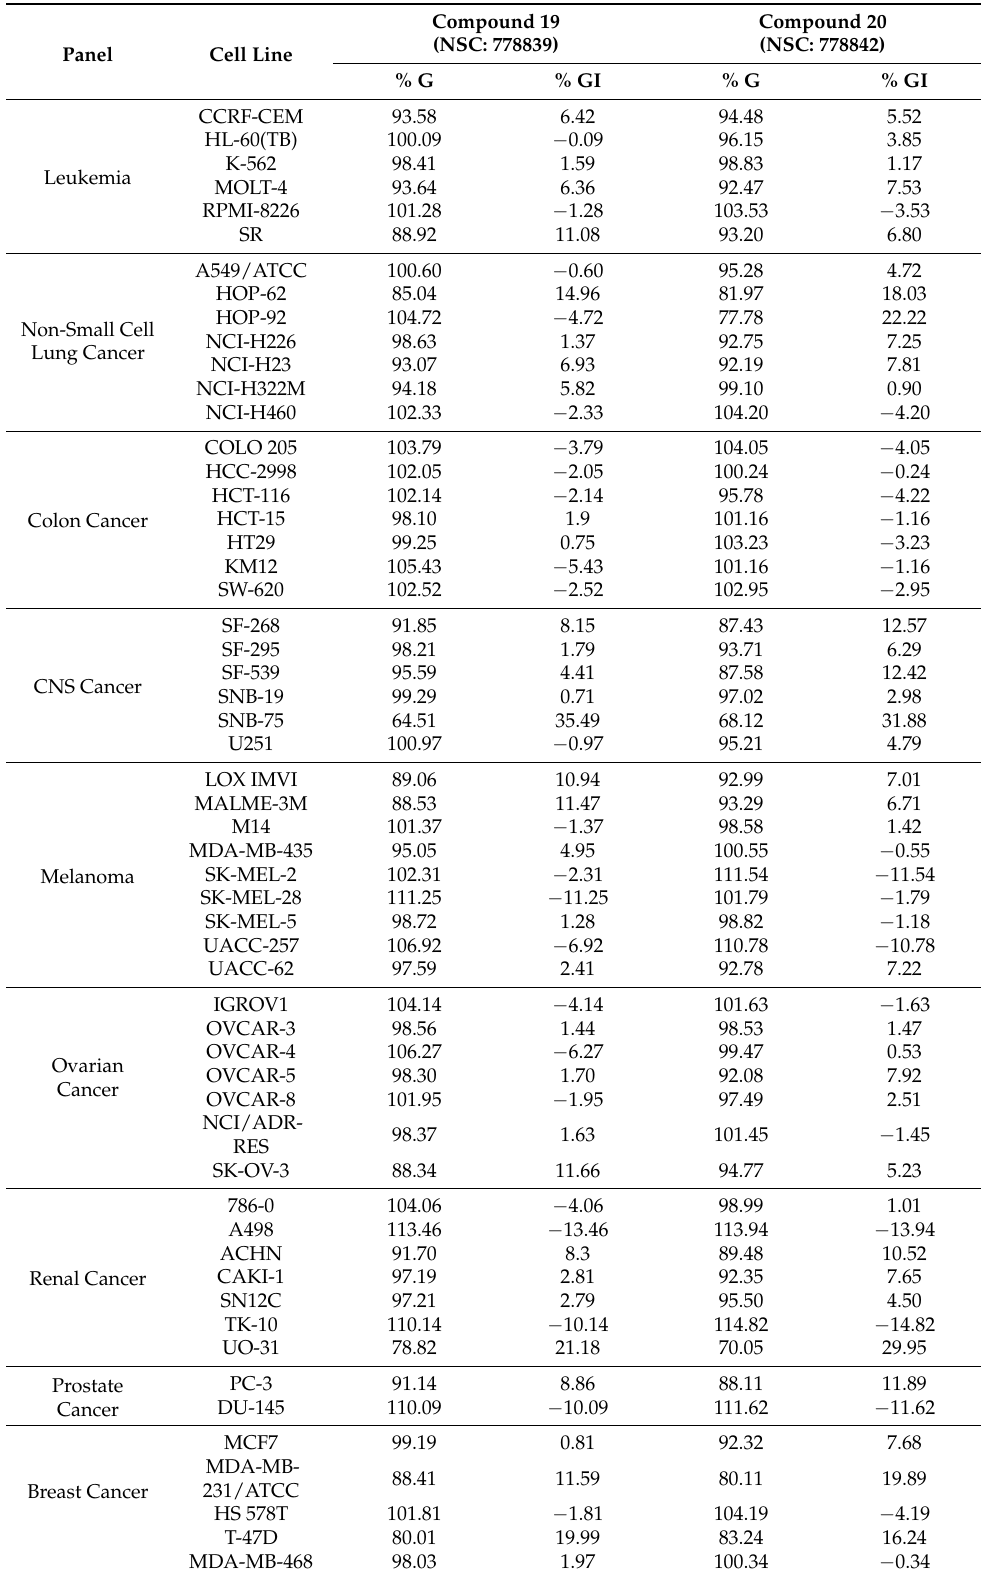
Table 4. In vitro anticancer screening of compound 19 and 20 , against NCI60 cell lines at 10 µ M